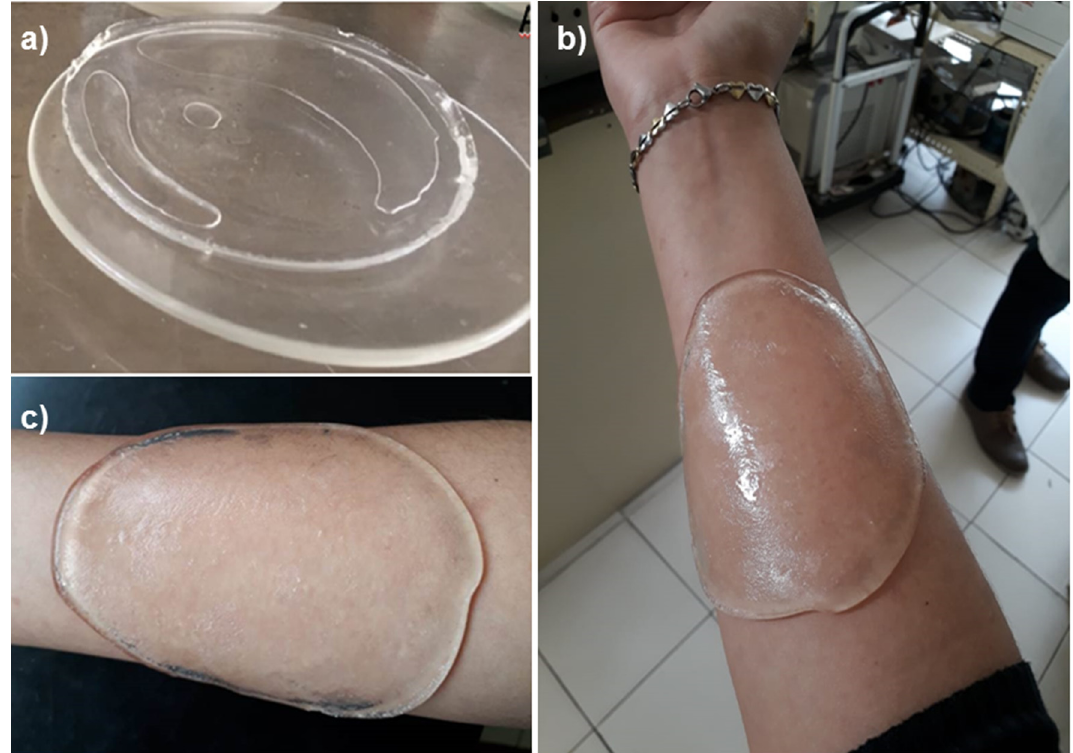
Figure 1. Images of synthesized hydrogels: ( a ) hydrogel freshly washed, ( b ) hydrogel adhered to the skin, ( c ) adhered hydrogel to the skin despite inclination.